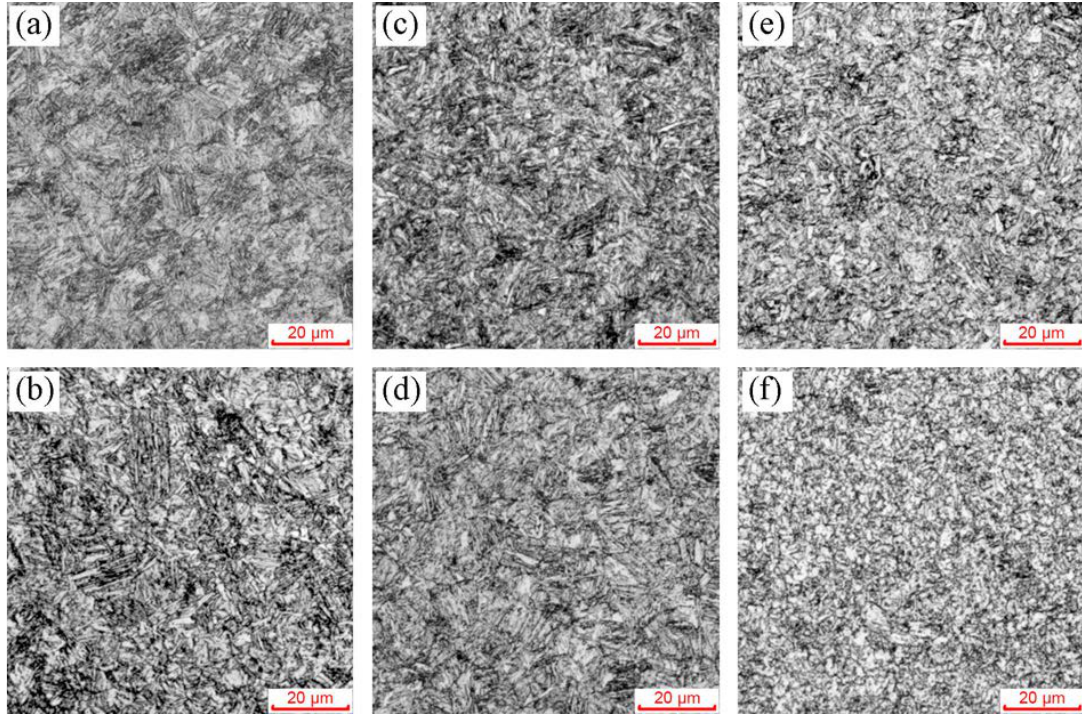
Figure 5. OM micrographs of three steels after one-step Q&P treatment: ( a , b ) 0V, ( c , d ) 0.03V, and ( e , f ) 0.16V, partitioned for ( a , c , e ) 90 s and ( b , d , f ) 200 s.